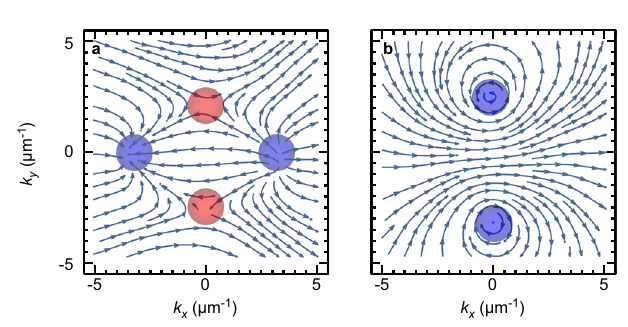
Fig. 3 | Hermitian topological transition. Experimental pseudospin texture in S 1 - S 2 plane of lower energy band for the ( a ) ( N +2, N ) case (4 Dirac points, zero winding) and ( b ) ( N , N ) case (2 Dirac points, winding